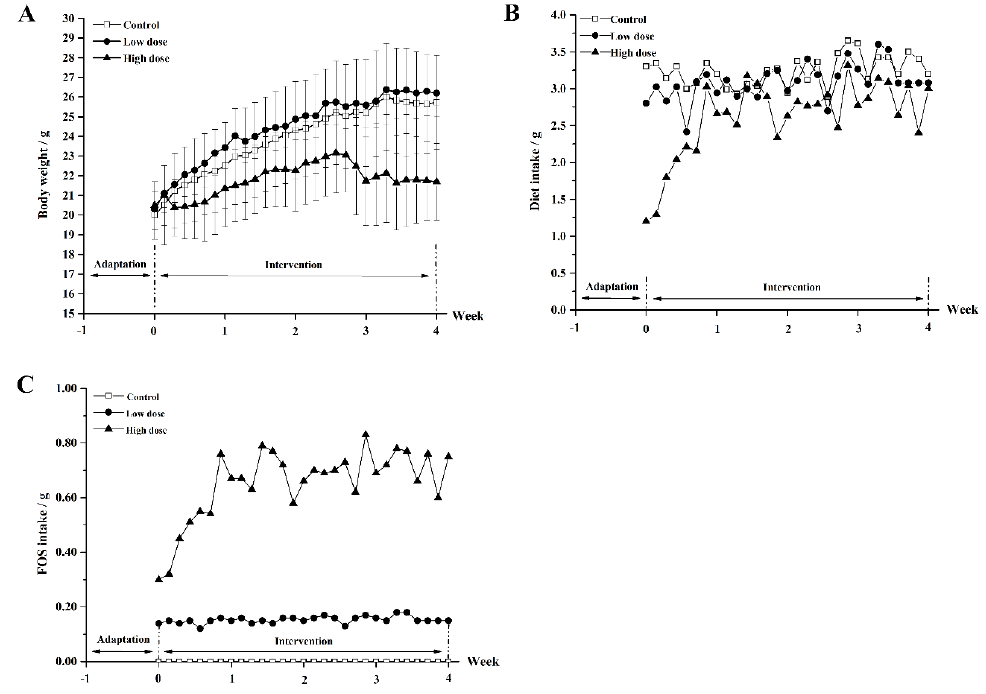
Figure 2. The body weight of mice ( A ), the dietary intake ( B ), and FOS intake ( C ) of mice in the three groups during the intervention period.